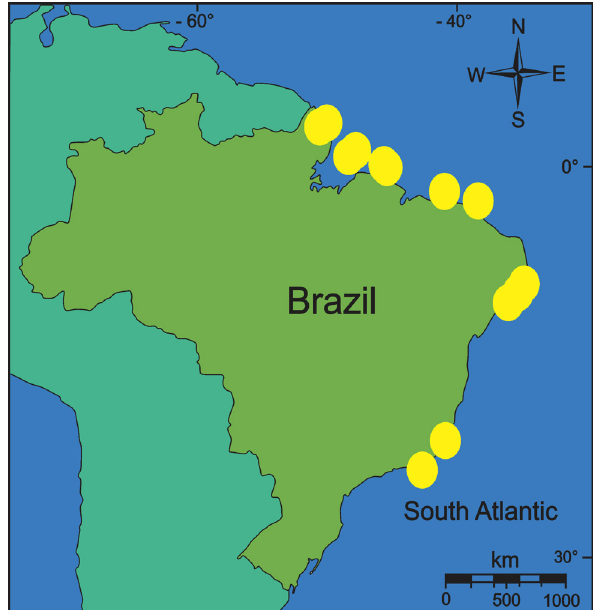
Figure 12. Distribution of Excorallana richardsoni Lemos de Castro, 1960 for Brazilian